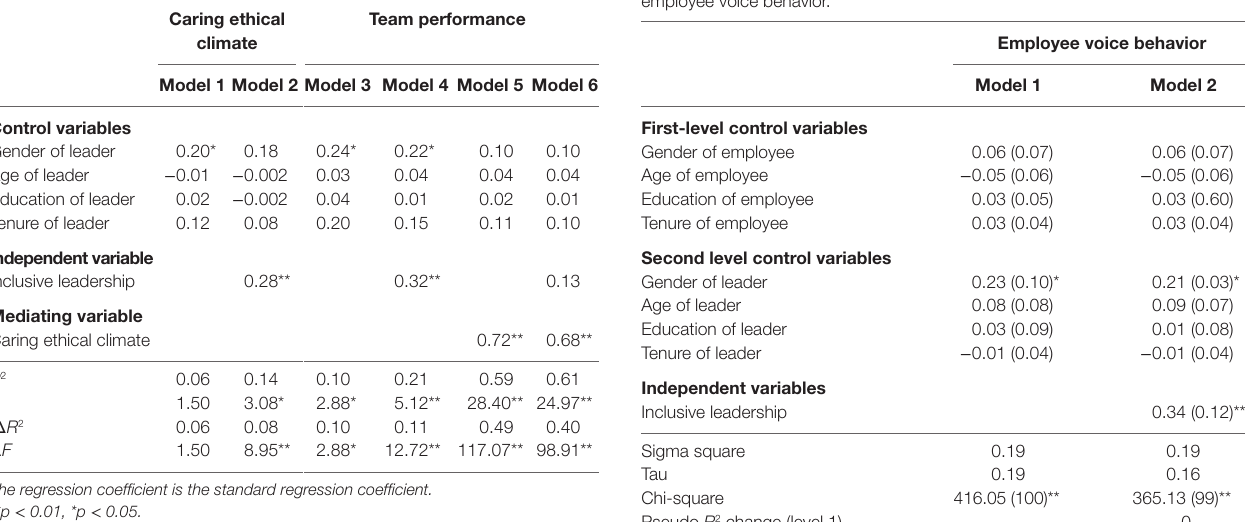
TaBle 4 | Mediating role of caring ethical climate testing at the team